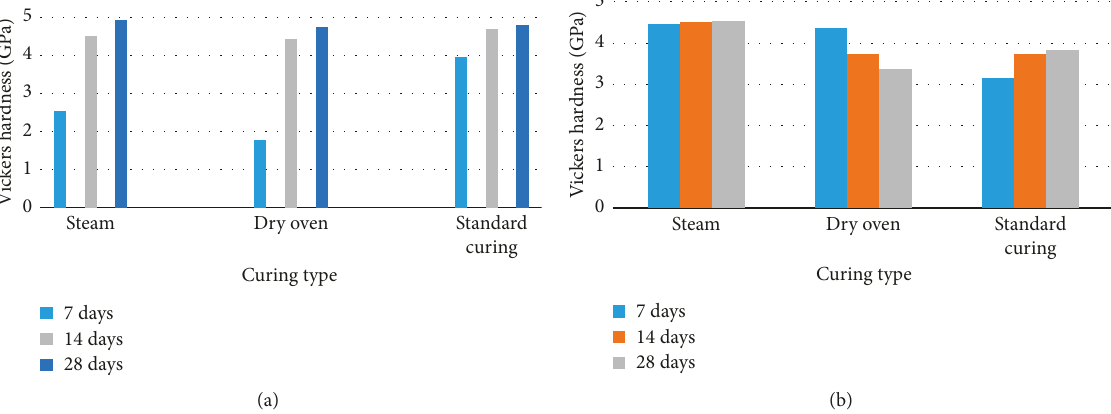
Figure 9: Vickers hardness of concrete specimens with a W/B ratio of 0.4 prepared and cured under different conditions at a temperature of (a) 30 ° C and (b) 50 °